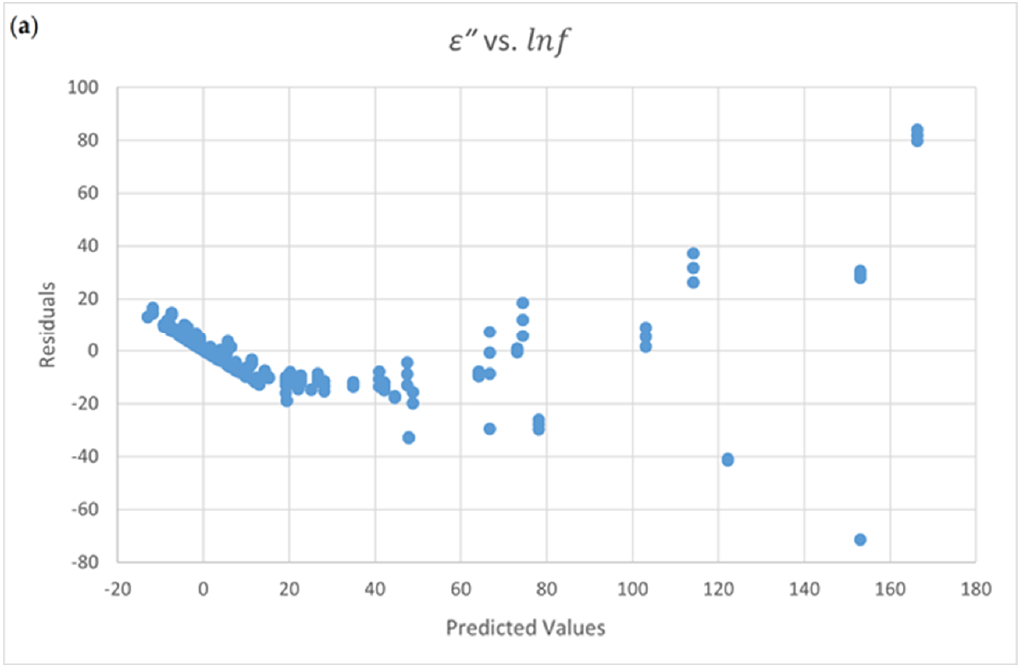
Figure 4. Residual plots for the dielectric constant ε’ equation for chicken flour (Guo et al. data [11]); ( a ). ε ′ vs. (cid:1858) ; ( b ). 1/ ε ′ vs. f.